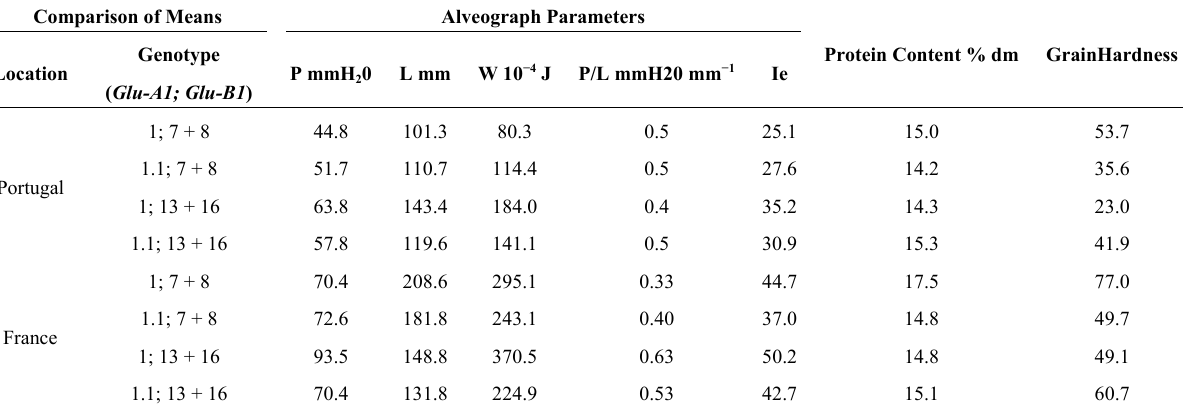
Table 2. Analysis of the impact of the allelic variation on quality parameters in wheat lines containing either 1Ax1.1 or 1Ax1 HMW-GS. Quality parameters are kernel protein content, grain hardness, tenacity (P), extensibility (L), deformation energy